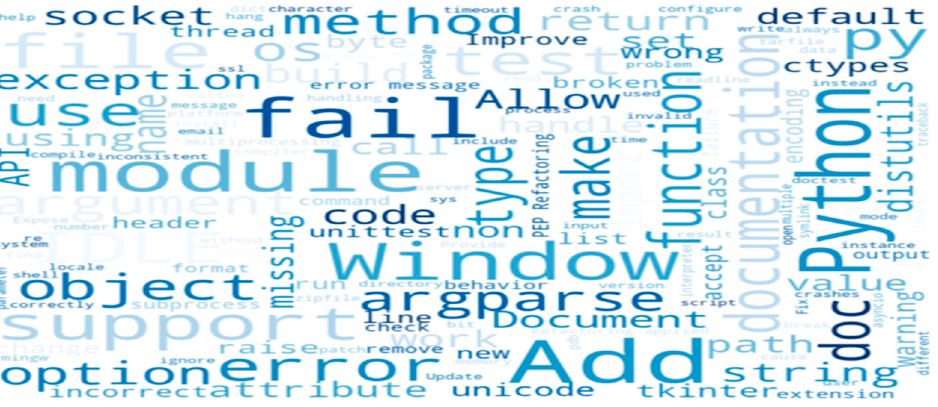
Figure 9. Word cloud of “Compile” error.